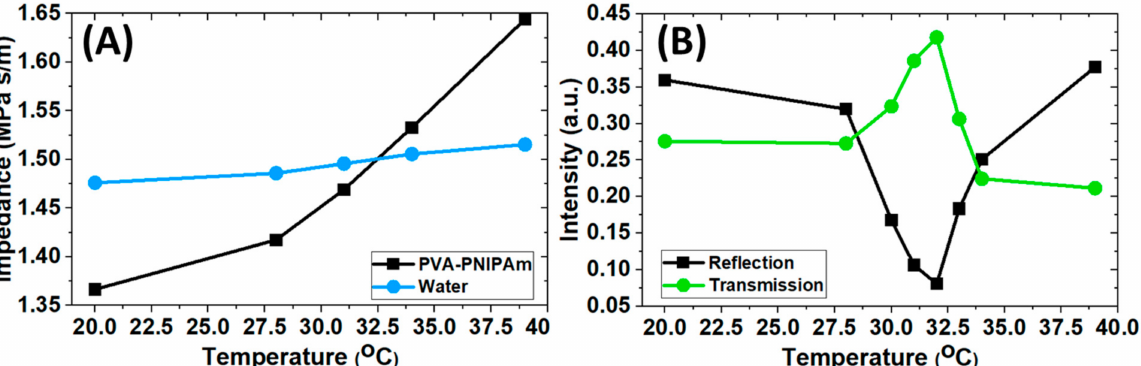
Figure 1. ( A ) Experimentally characterized temperature-dependent acoustic impedance of PVA-pNIPAM hydrogel and the comparison with water. ( B ) Experimental transmission and reflection behavior of the hydrogel in water ambient at varying operating